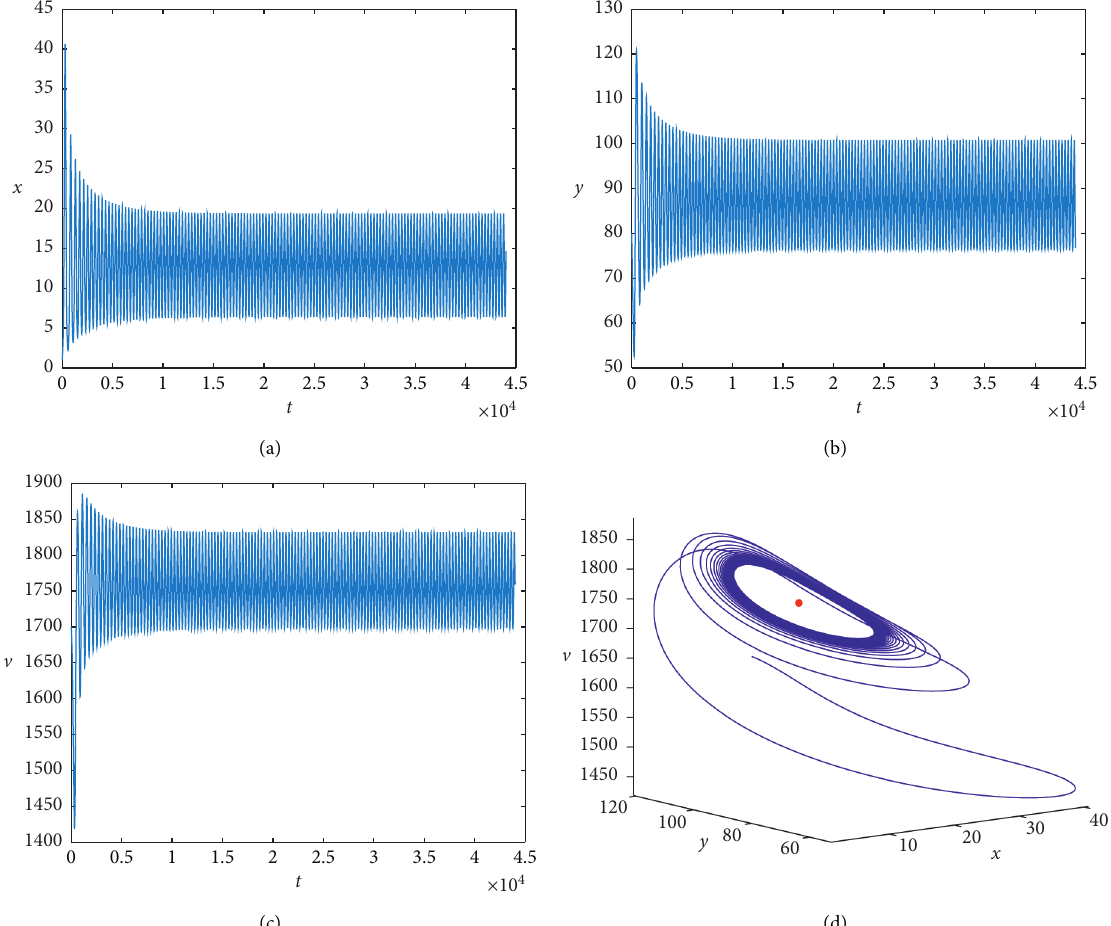
Figure 5: Illustration of basic behavior of solutions of system (4) with τ � 0 . 54 > τ (a) time series of x ( t ), (b) time series of y ( t ), (c) time series of v ( t ), and (d) phase trajectories of x ( t ), y ( t ), and v ( t